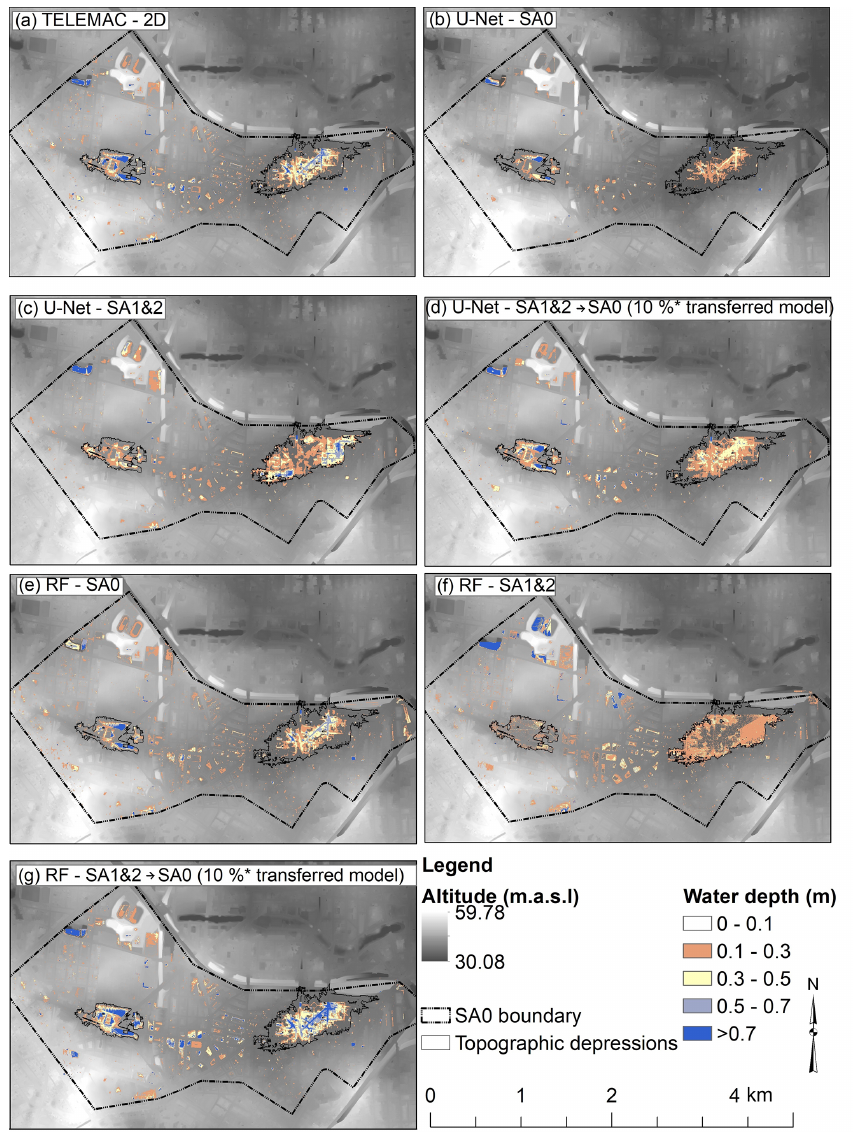
Figure 6. Comparison of water depths from different models and TELEMAC-2D model for a 100mm precipitation event for SA0. The figure highlights the boundary of two topographic depressions within SA0 where runoff accumulates. The altitude is shown in the